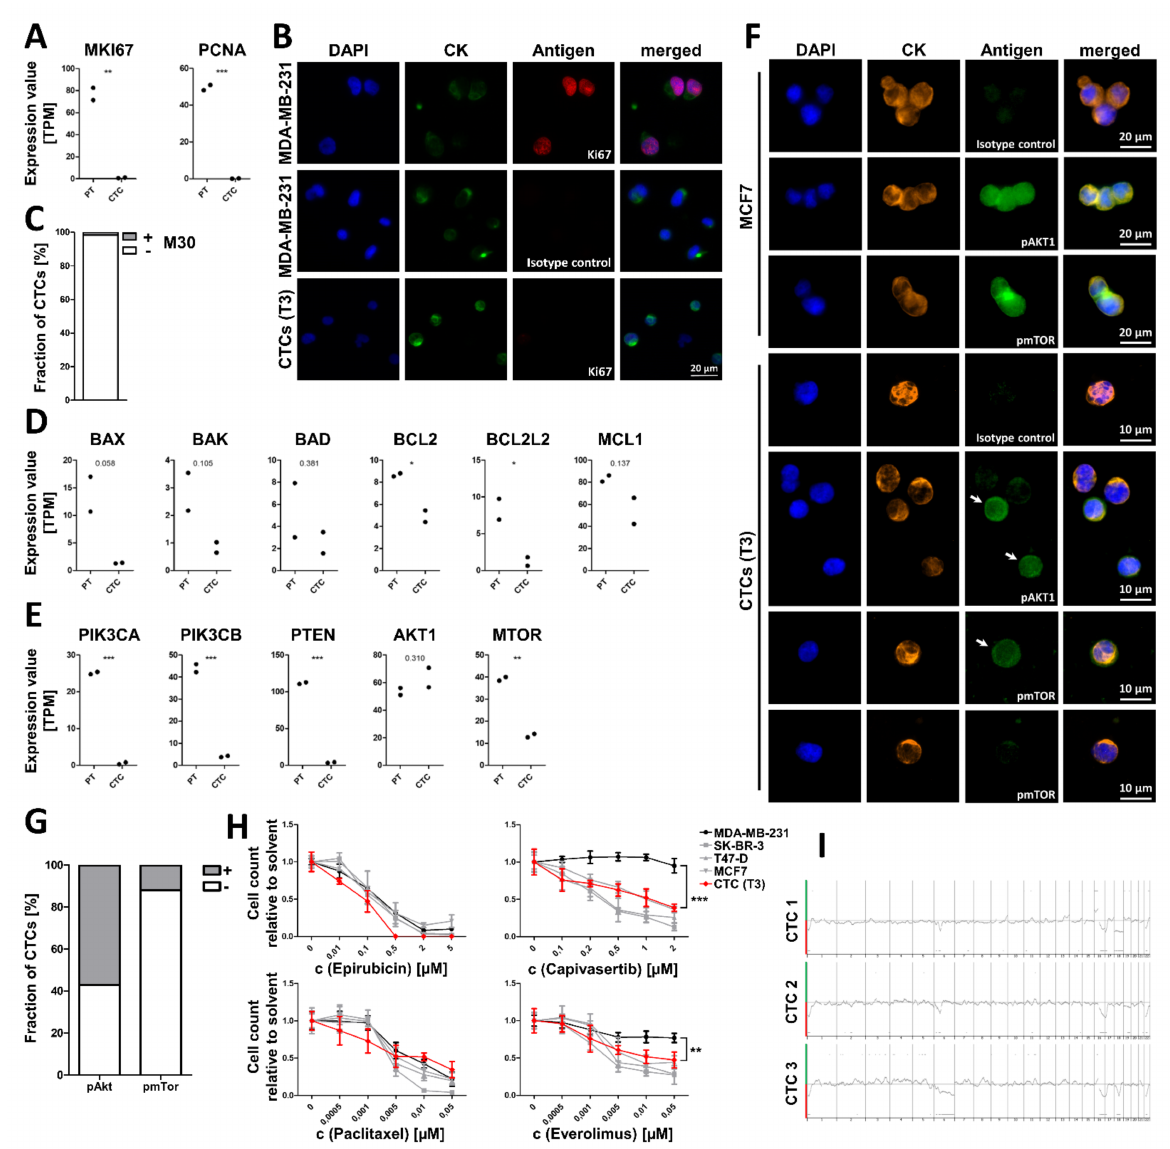
Figure 5. Analysis to predict the efficacy of a treatment targeting the AKT1/mTOR pathway in patient 1: Gene expression data were generated by RNA sequencing of bulk circulating tumor cells (CTCs) and the primary tumor (2 replicates each). Statistical significance levels were determined with a two-tailed t -test. Selected genes are involved in proliferation ( A ), regulation of apoptosis ( D ), and regulation of the PI3K/AKT1/mTOR pathway ( E ). ( B ) Expression of the proliferation marker Ki67 analyzed by immunocytofluorescence analysis. Ki67 positive cells from the MDA-MB-231 cell line served as references (original magnification 40 × ). ( C ) Apoptosis status as determined by staining for caspase cleaved cytokeratin 18 (M30) (Supplementary Figure S7). Positive cells were deemed apoptotic. ( F ) Immunofluorescence analysis of phosphorylated AKT1 (Ser473) and phosphorylated mTOR (Ser2448). Cells from the MCF7 cell line served as positive control. Positive CTCs are highlighted with arrows (original magnification 40 × ). ( G ) Ratio of CTCs positive/negative for phosphorylated AKT1 and phosphorylated mTOR. ( H ) The drugs epirubicin, capivasertib, paclitaxel, and everolimus were tested with in vitro cultured CTCs. As references, cells from SK-BR-3, T47-D, MCF7 (all sensitive to treatment with capivasertib and everolimus; shown in grey), and MDA-MB-231 cell lines (resistant to treatment with capivasertib and everolimus; shown in black) were used. Statistical significance levels were determined by a two-way ANOVA with post hoc Bonferroni test. Error bars show standard deviation. ( I ) Copy number aberration profiles of remaining CTCs at T36. Green indicates a signal below the baseline representing a copy number gain. Red indicates a signal below the baseline representing a copy number loss. *** Indicates a p -value < 0.001, ** indicates a p -value < 0.01, * indicates a p -value < 0.05; TPM (transcripts per million); CK